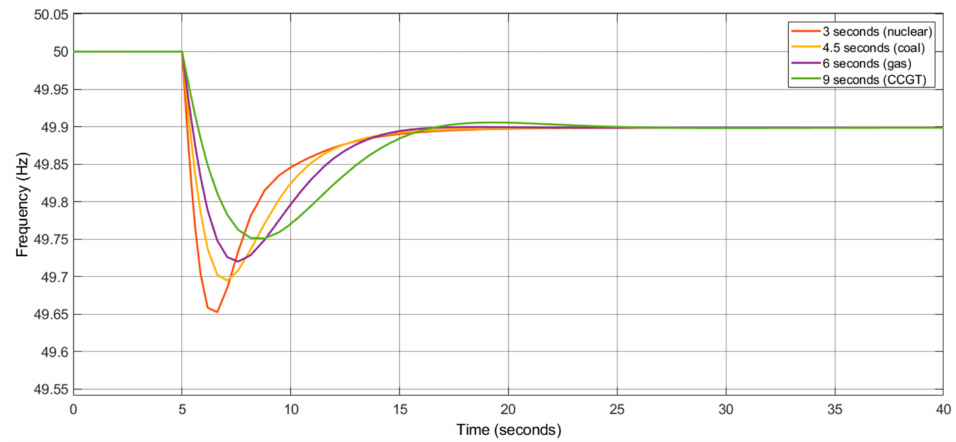
Figure 9. Impact of the changes of systems inertia on the primary frequency